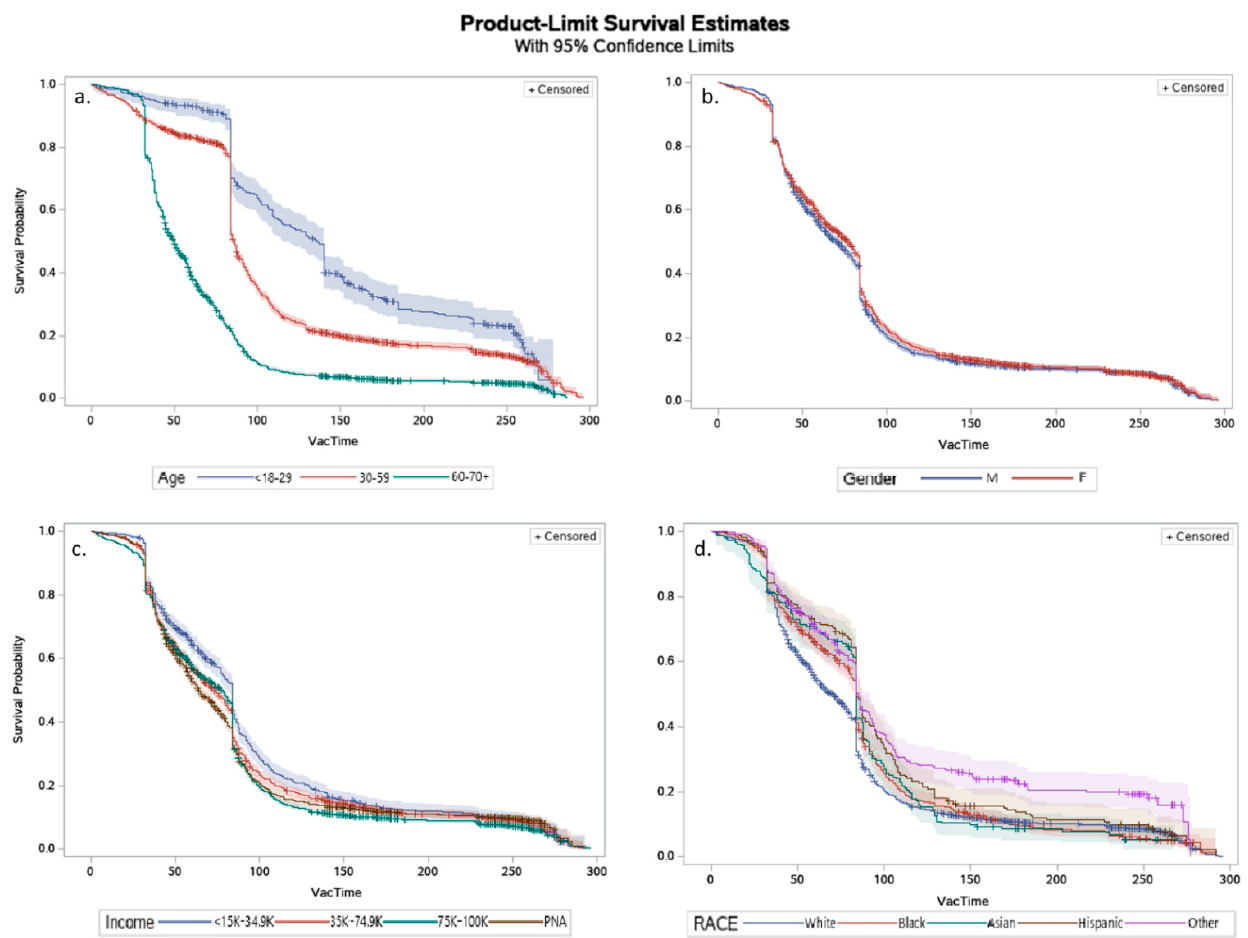
Figure 4. Kaplan-Meier survival curves demonstrating differences in receipt of vaccine for socio- demographic exposures: ( a ) age; ( b ) gender; ( c ) income; ( d ) race. mographic exposures: ( a ) age; ( b ) gender; ( c ) income; ( d )